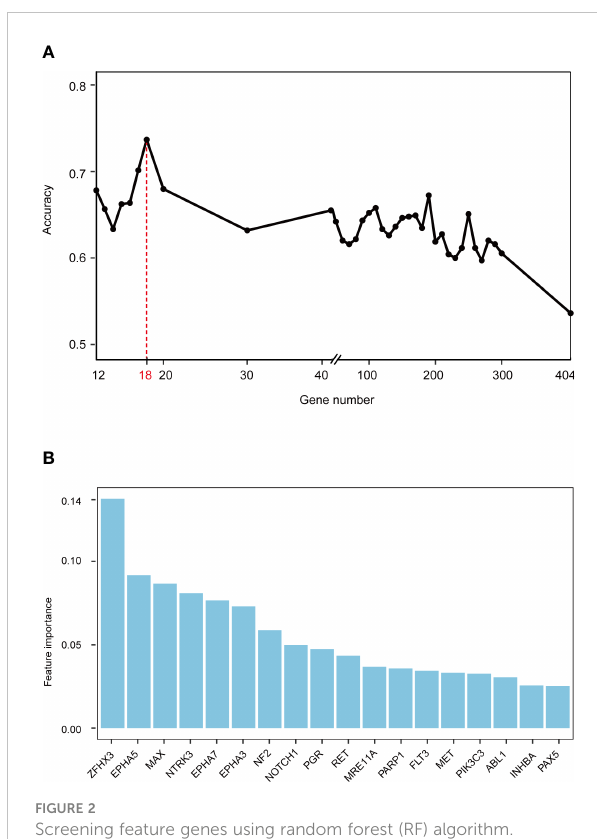
FIGURE 2 Screening feature genes using random forest (RF) algorithm. (A) Feature combination selection. The combination of 18 genes can achieve the highest classi fi cation accuracy with the least number of variables. (B) Feature importance of 18 genes.